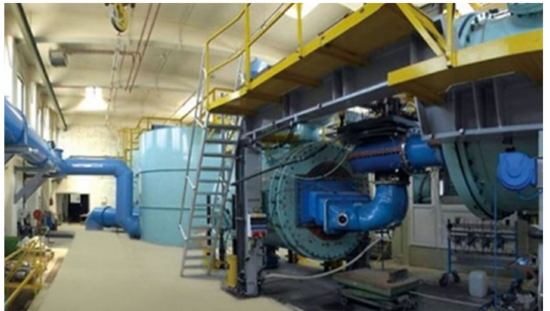
Figure 1. One of the five model-test rigs in the Andritz Hydro Laboratory in Linz, Austria.